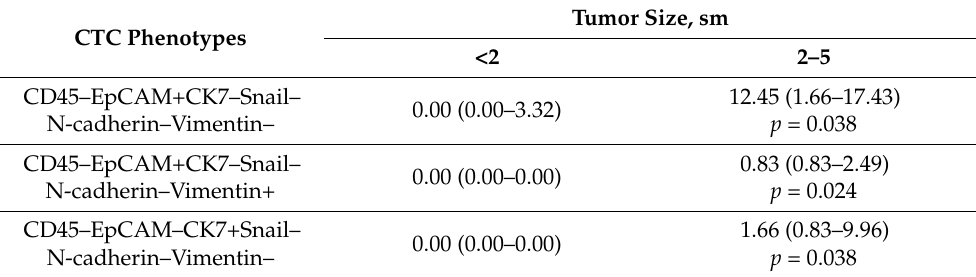
Table 2. The number of different CTCs subsets with heterogeneous manifestations of epithelial– mesenchymal